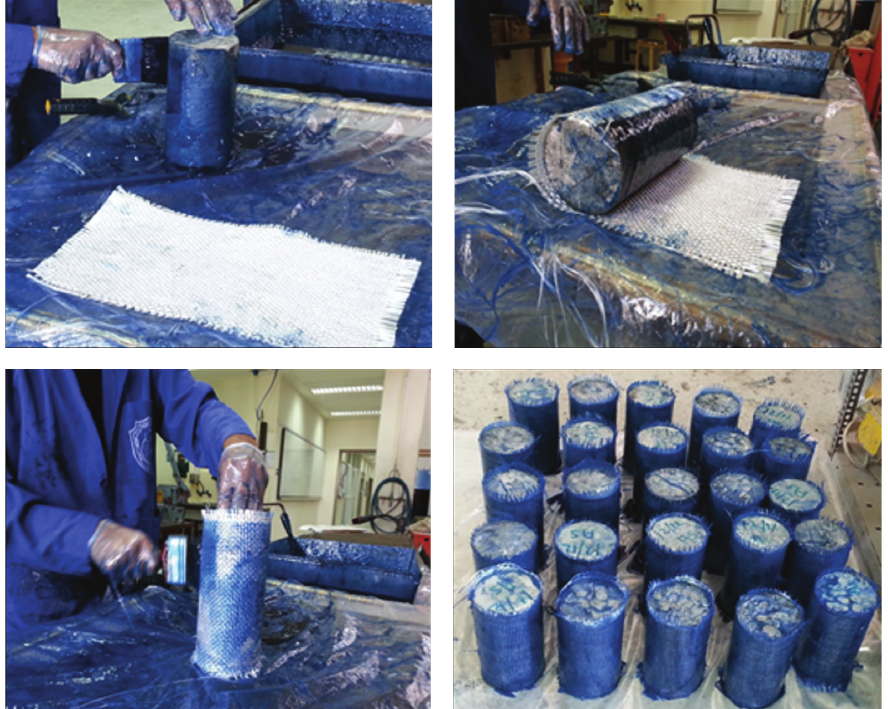
Figure 5: Steps of confining